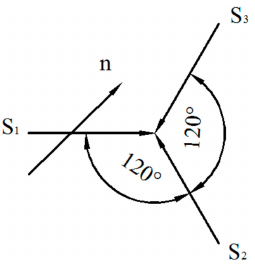
Figure 11. Shear strains caused by equivalent ε variants in one habit